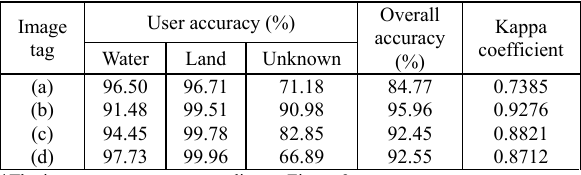
Table 2. Accuracy evaluation result of the Maximum